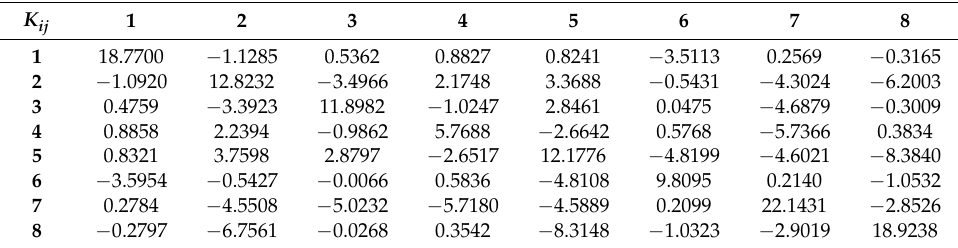
Figure 6. The position adjustment curve of node 1 by the Proportion-Integral (PI) controller. Table 3. Feedback matrix K of the eight actuators for the lower left plate.